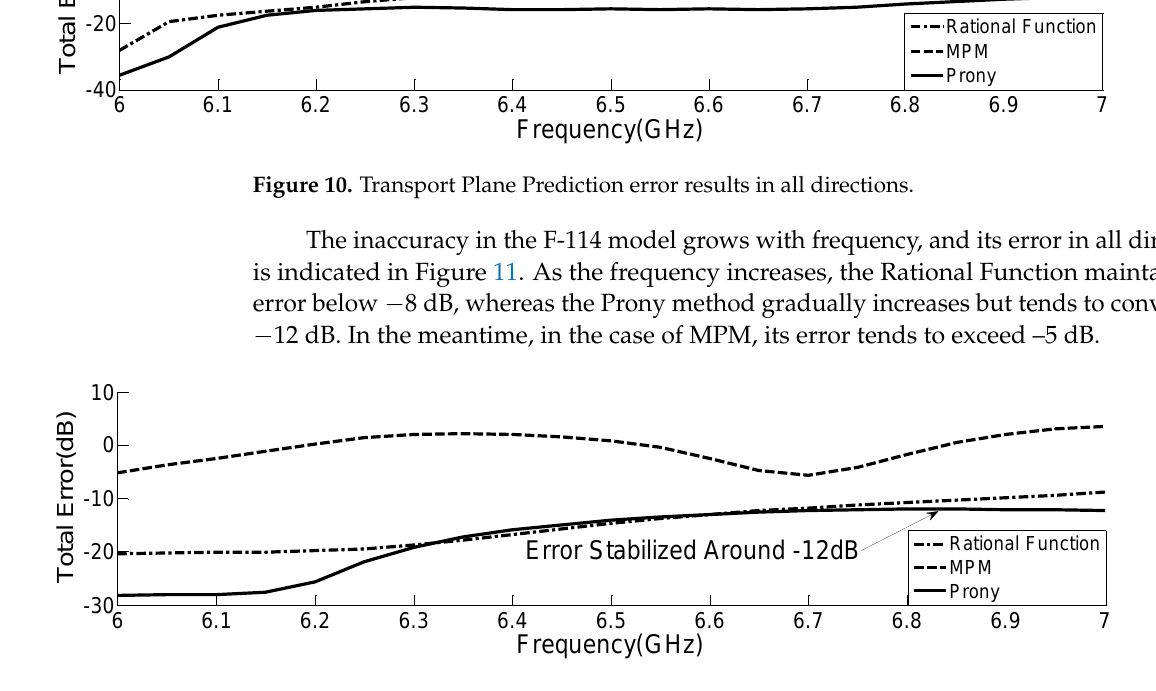
Figure 11. F-117 Prediction error results in all directions.